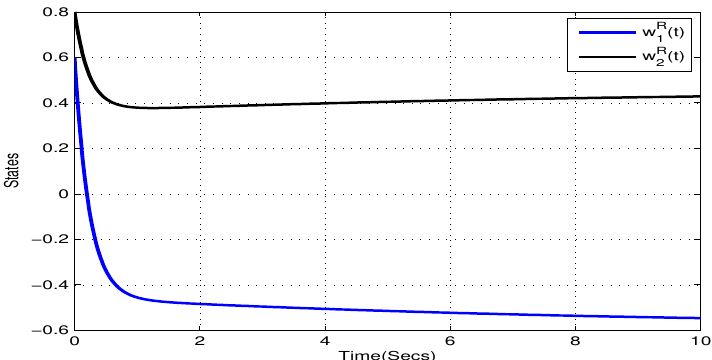
( t ) , w R ( t ) of systems (23) with state feedback control u 2 1